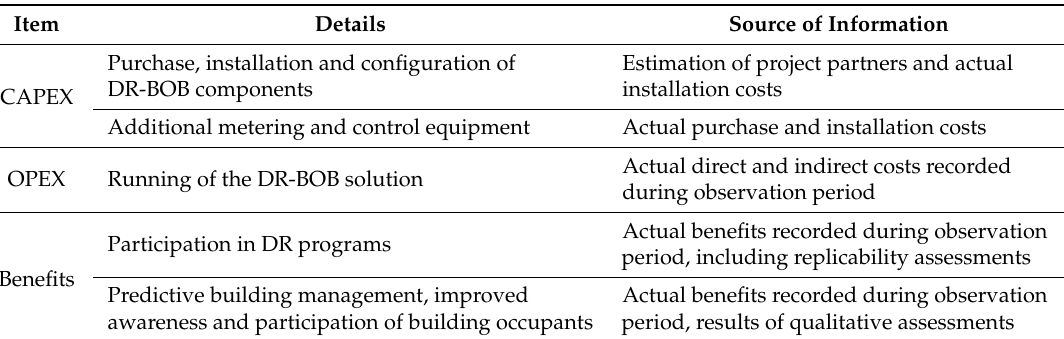
Table 5. Data recorded for the cost-benefit